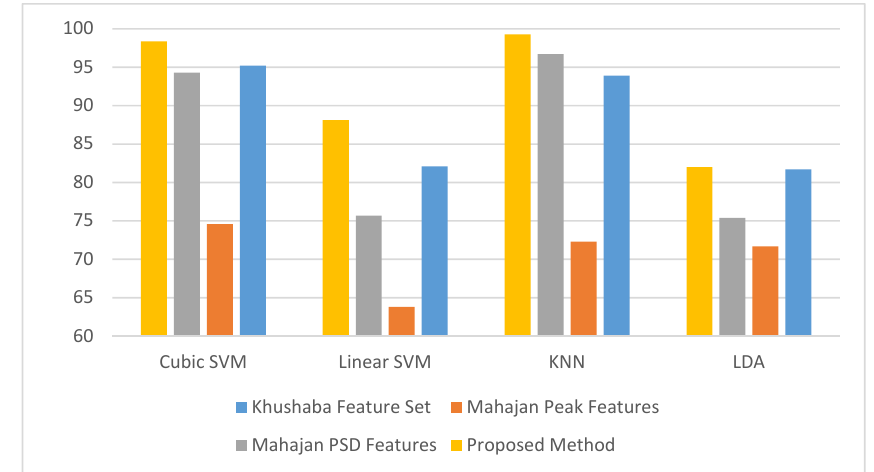
Figure 15. The classification accuracies for classifying stress levels using our proposed Feature-Set 3 compared to Khushaba et al. [22] and the two feature-sets from Mahajan [18].